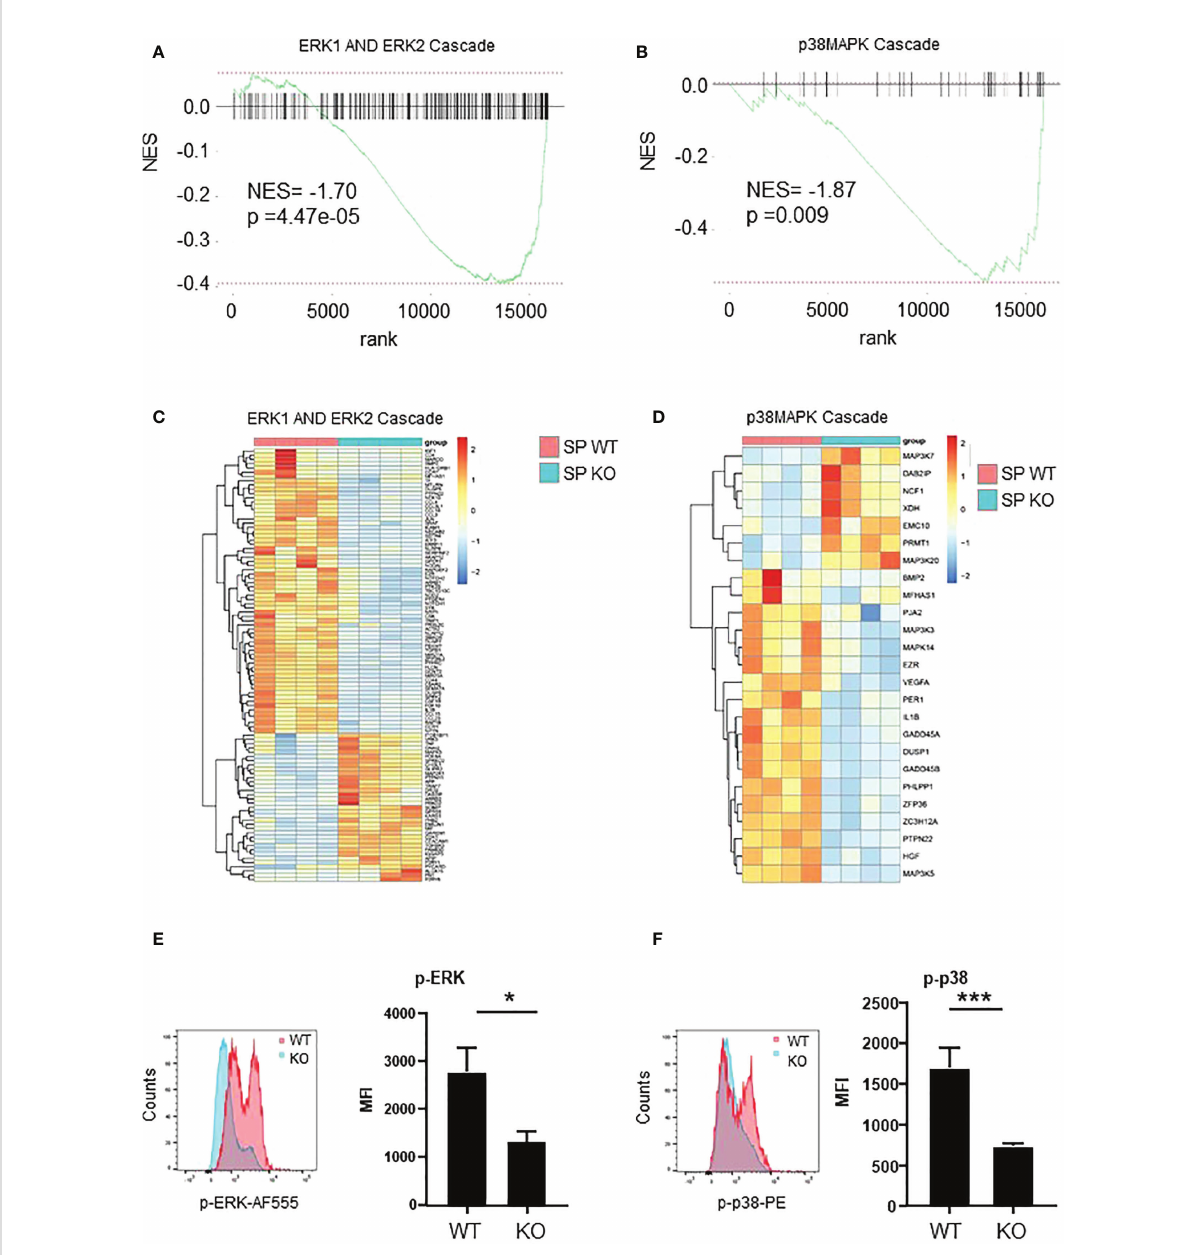
FIGURE 7 ERK and p38 pathways are down-regulated in Spleen Cxcr2-/- neutrophils. (A) NES after GSEA analysis of the transcriptome of spleen neutrophils isolated from Cxcr2-/- versus WT animals according to ERK1 and ERK2 cascade signature. (B) Same analysis for p38-MAPK signature. (C) Heatmap of the signi fi cantly regulated genes (p<0.05) of GO-BP ERK1 and ER2 cascade signature. (D) Heatmap of the signi fi cantly regulated genes (p < 0.05) of GO-BP p38 MAPK cascade signature. (E) Phospho-p42/44 MAPK ERK1/2 (Thr 202/Tyr 204) was analyzed by fl ow cytometry in spleen CD11b+ Ly6G+ neutrophils. Left panel: representative Mean of Fluorescence (MFI) of WT (red line) and KO (blue line) Ly6G+ neutrophils. Results are expressed as MFI of phospho-ERK positive neutrophils in the CD11b+ Ly6G+ population and represent the mean ± SEM of at least 6 animals (Mann-Whitney test, *p < 0.05). (F) Phosphorylation of p38MAPK on Thr180/Tyr182 was analyzed by fl ow cytometry in the same conditions (Mann-Whitney test, ***p <